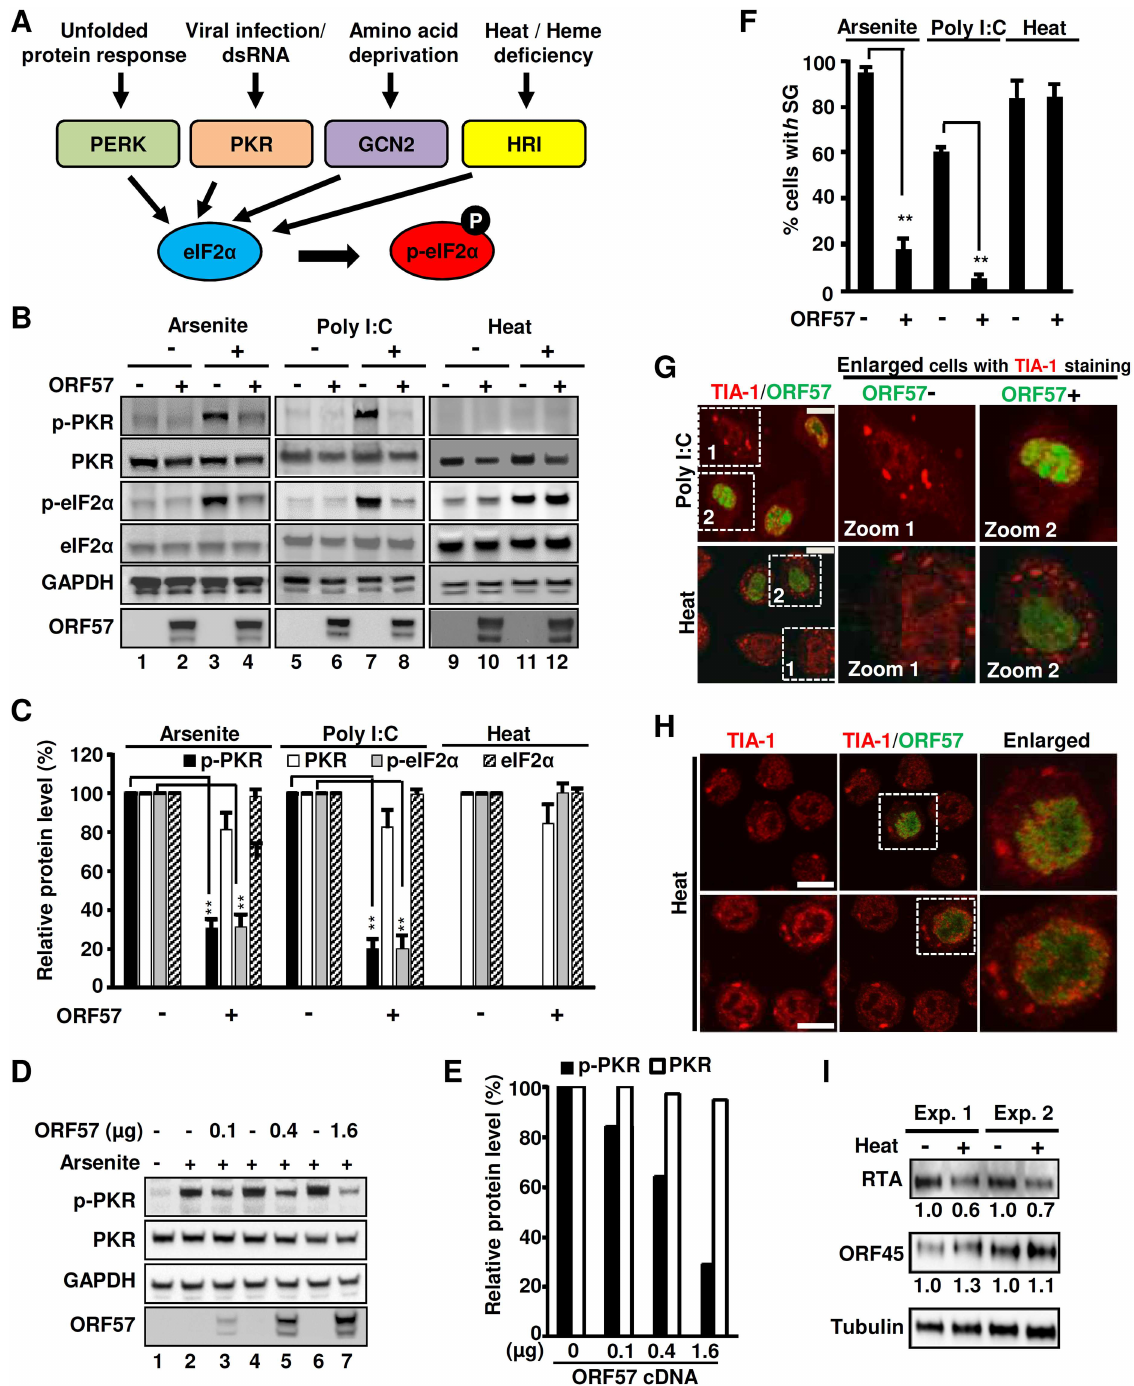
Fig 4. Viral ORF57 inhibits eIF2 α phosphorylation through down-regulation of PKR pathway. (A) Diagramsof four major stress pathways leadingto phosphorylation of eIF2 α via different kinases. PERK, PKR-likeendoplasmic reticulumkinase; PKR, protein kinase R; GCN2, generalcontrol nonderepressible2; HRI, heme regulatedinhibitorykinase. (B-C) ORF57 selectively inhibitsthe arsenite- or poly I:C-inducedphosphorylation of both PKR and eIF2 α , but not heat-induced phosphorylation of elF2 α . HeLa cells transfected with an ORF57-Flag expressingvector or an empty Flag vector for 24 h were treated with arsenite, poly I:C or heat. The relative levels of p-eIF2 α (Ser 51), phospho-PKR (Thr 451), total eIF2 α , and total PKR in each sample were determined by Western blot with the corresponding antibodiesand are plotted in bar graphs(C), with the expressionlevel in the sample without ORF57 being set to 100%after normalized to GAPDH which served as a loadingcontrol. ** P < 0.01in student t -test.